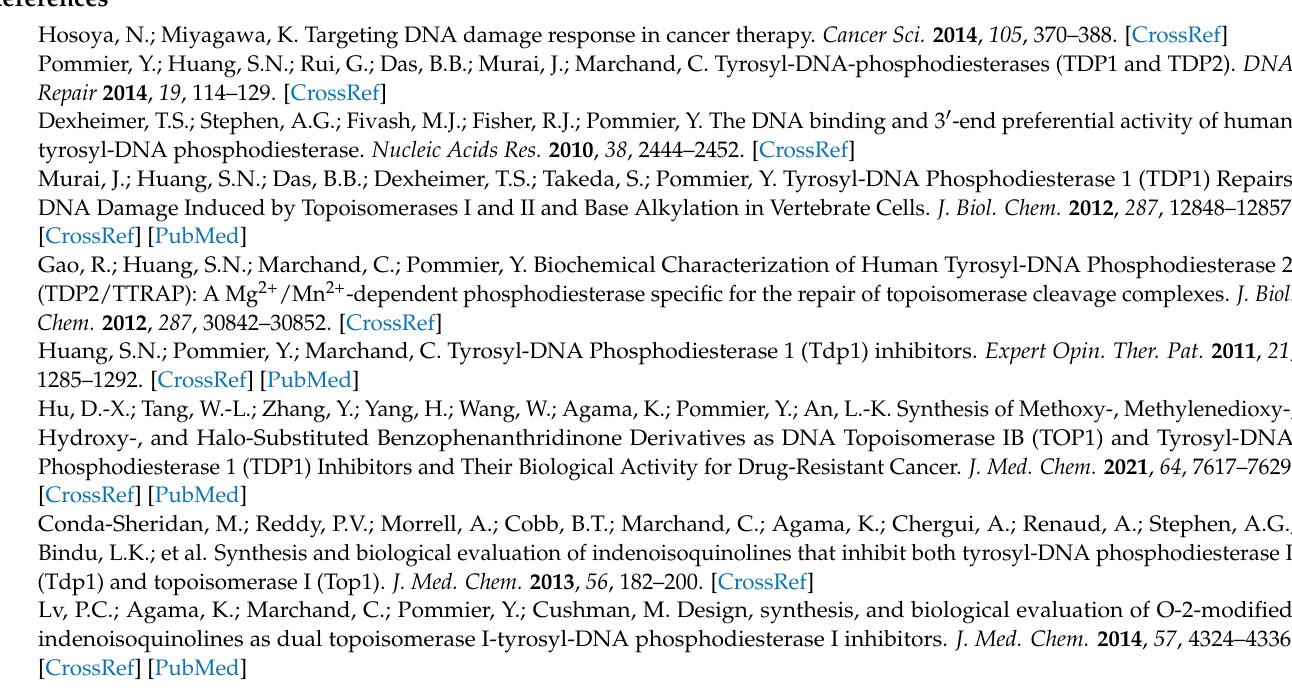
against HeLa cells; Molecular modeling section. Further discussion and details are given for the modeling results; Table S3. The binding affinities as predicted by the scoring functions used to the TDP2 binding site as well as the RMSD values for the co-crystallized ligand (6FQ); Table S4. The binding affinities as predicted by the scoring functions used for the catalytic TDP1 binding pocket; Table S5. The molecular descriptors and their corresponding Known Drug Indexes 2a and 2b (KDI 2a/2b ). The R 2 numbers derived do not contain derivatives 13 and DCA since they are outliers; Table S6. Definition of lead-like, drug-like, and Known Drug Space (KDS) in terms of molecular descriptors. The values given are the maxima for each descriptor for the volumes of chemical space used; Table S7. Structures of DCA derivatives. Effect of benzyloxy vs. acetoxy groups in the steroid scaffold on TDP1; Table S8. Structures of DCA derivatives. Effect of benzyloxy vs. methoxy groups in the steroid scaffold on